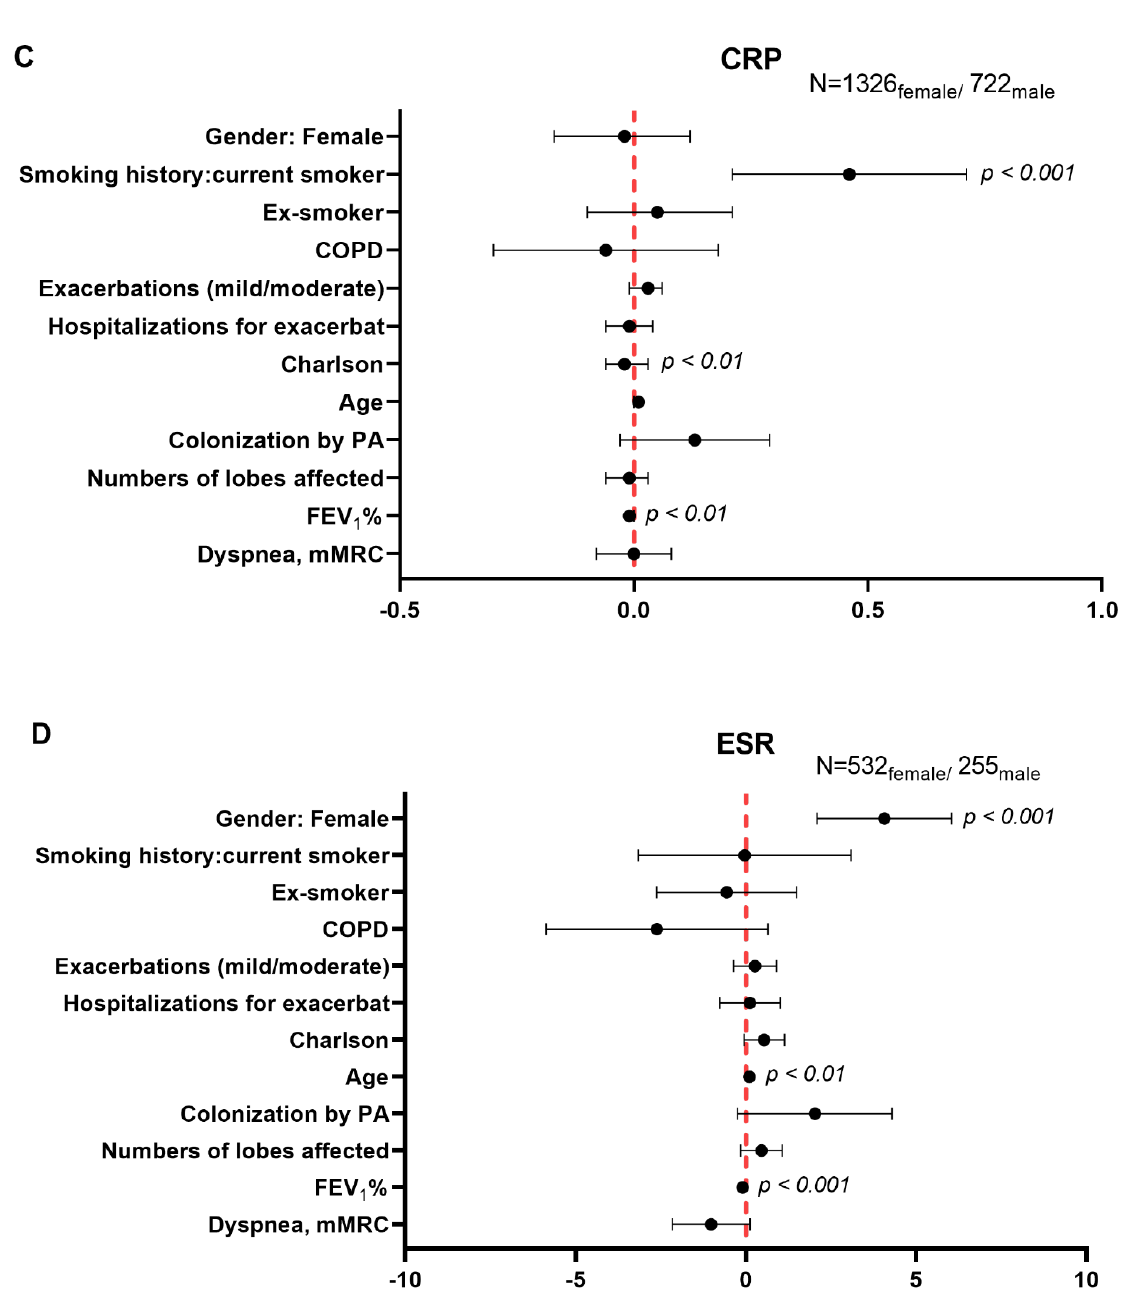
Figure 4. Independent associations between female gender and the following variables: total number of leukocytes ( A ), total number of neutrophils ( B ), CRP levels ( C ), ESR levels ( D ). Multivariate robust regression analysis was used to perform the analysis. Confidence intervals and statistical significance are represented in each figure panel. Beta coefficients are represented as black dots. The zero value is represented as a red dotted vertical line in each forest plot. The model was adjusted by age, smoking history (never, current, or ex-smokers), exacerbations mild-moderate, hospitalizations due to exacerbations in the previous year, Charlson Index, colonization by PA, numbers of affected lobes, FEV 1 %, and dyspnea score for each variable.